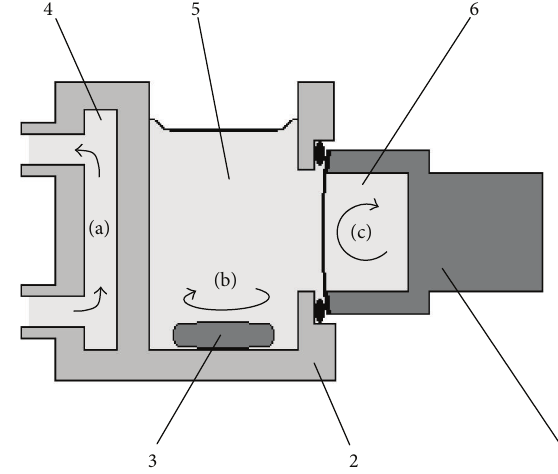
Figure 3: Thermostated measuring cell: (1) is oxygen sensor (Figure 2, a cathode is not shown), (2) is measuring cell (PMMA), (3) is mag- netic stirrer, (4) is heat carrier from thermostat, (5) is conditional incubation medium (KCl; 60g/L, 3.5 mL), and (6) is electrolyte of the sensor (KCl; 60g/L, 400 𝜇 L). (a) is circulation of heat carrier, (b) is mixing of the medium by a magnetic stirrer, and (c) is convective mixing of the electrolyte due to a temperature difference between the membrane and the sensor’s body. The temperature gradient between the heated incubation medium (5) and colder electrolyte (6) of oxygen sensor (1) causes convective mixing of the electrolyte (c). This significantly accelerates the gas exchange between the electrolyte and the medium